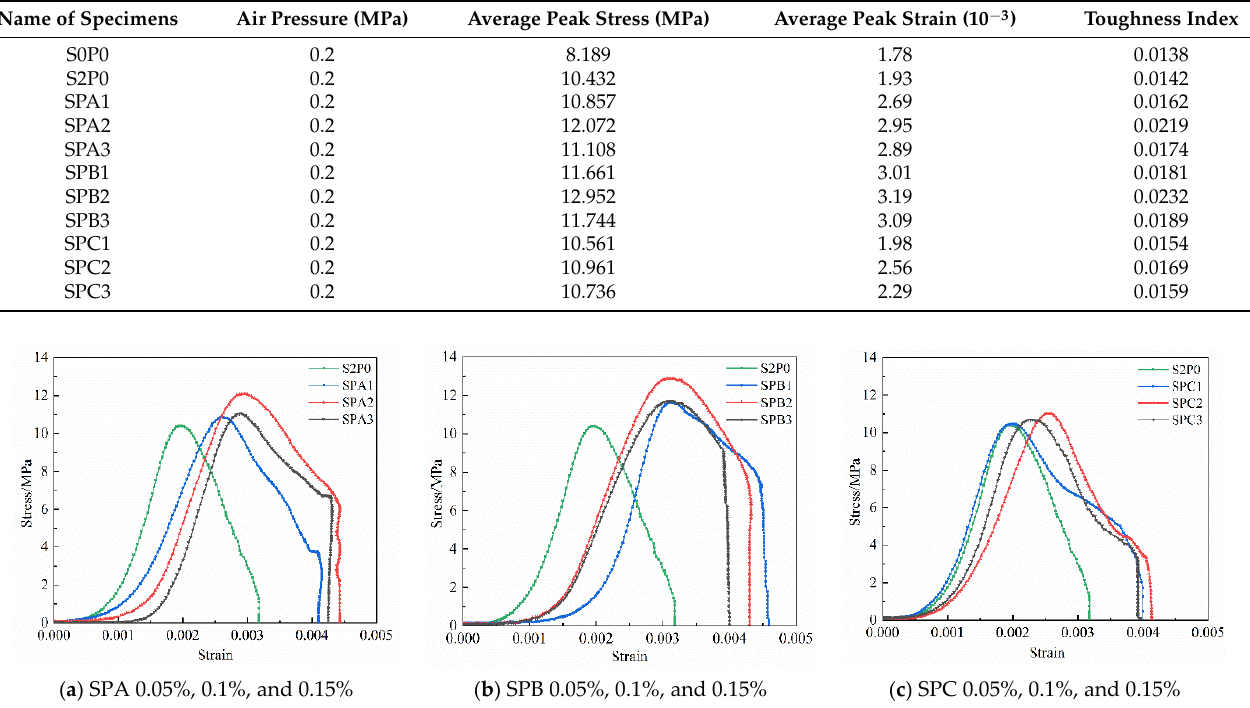
Table 7. SHPB dynamic split test results.